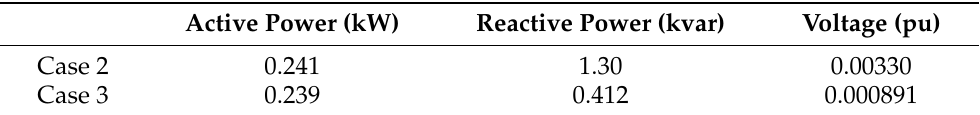
Table 1. MAEs of conventional (Case 2) and proposed (Case 3) methods over Case 1.